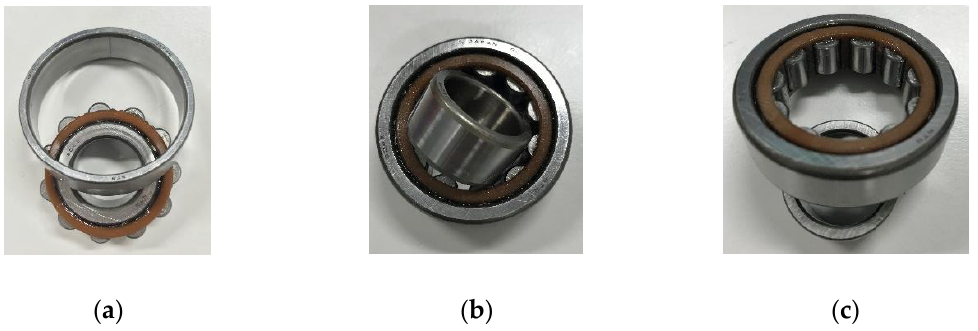
Figure 8. Example of bearing faults. ( a ) Outer race flaw. ( b ) Inner race flaw. ( c ) Rolling element flaw.